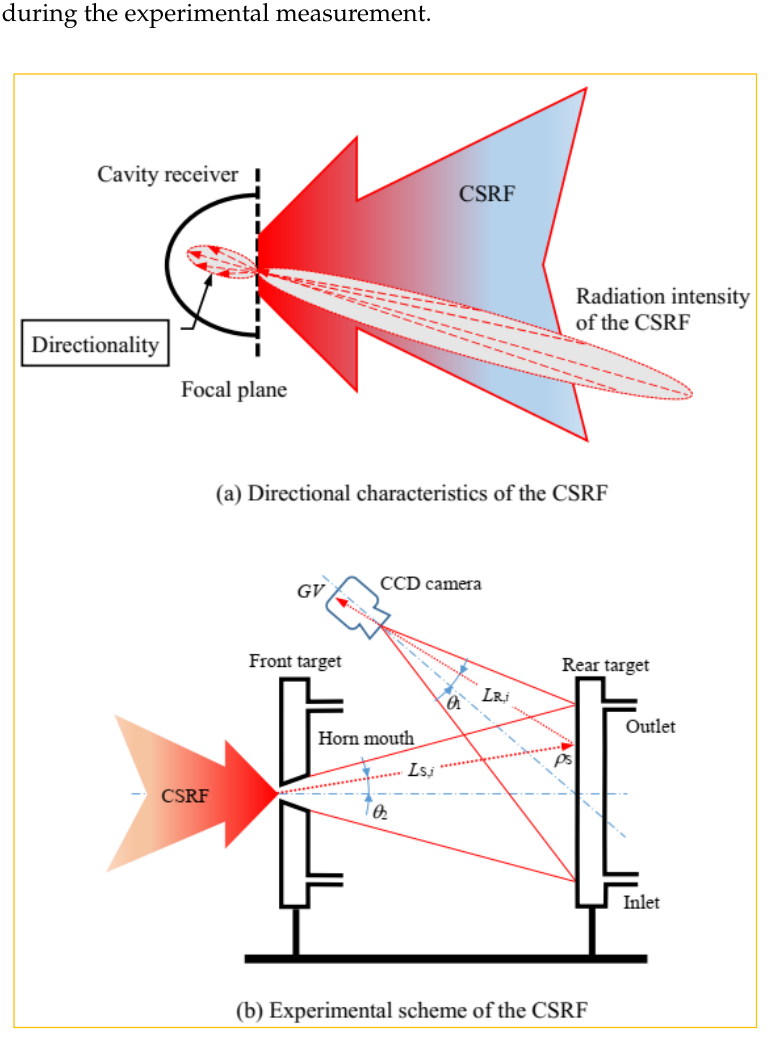
Figure 1. Optical path for the directional distribution measurement of the CSRF.